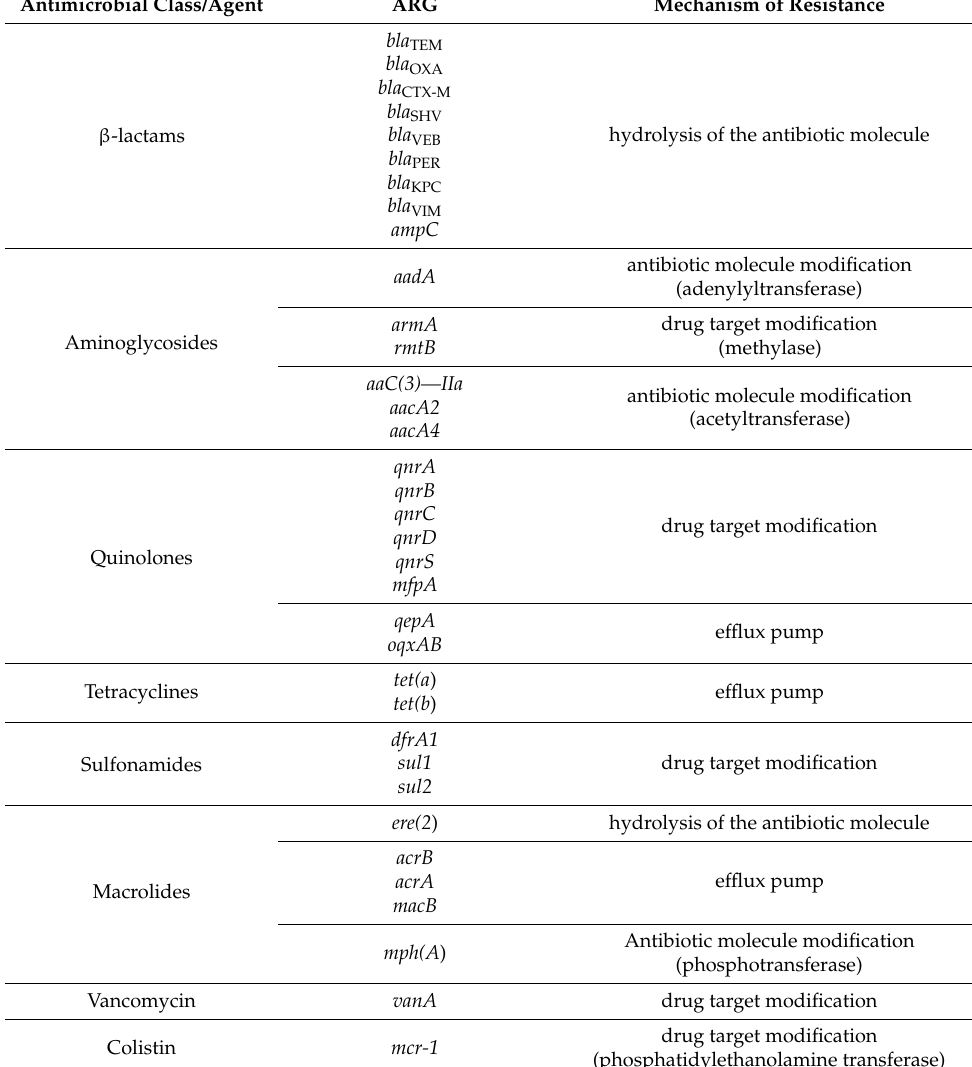
Table 1. The UPEC antibiotic resistance genes—ARGs, their mechanisms of action, and antimicrobials they affect. Antimicrobial